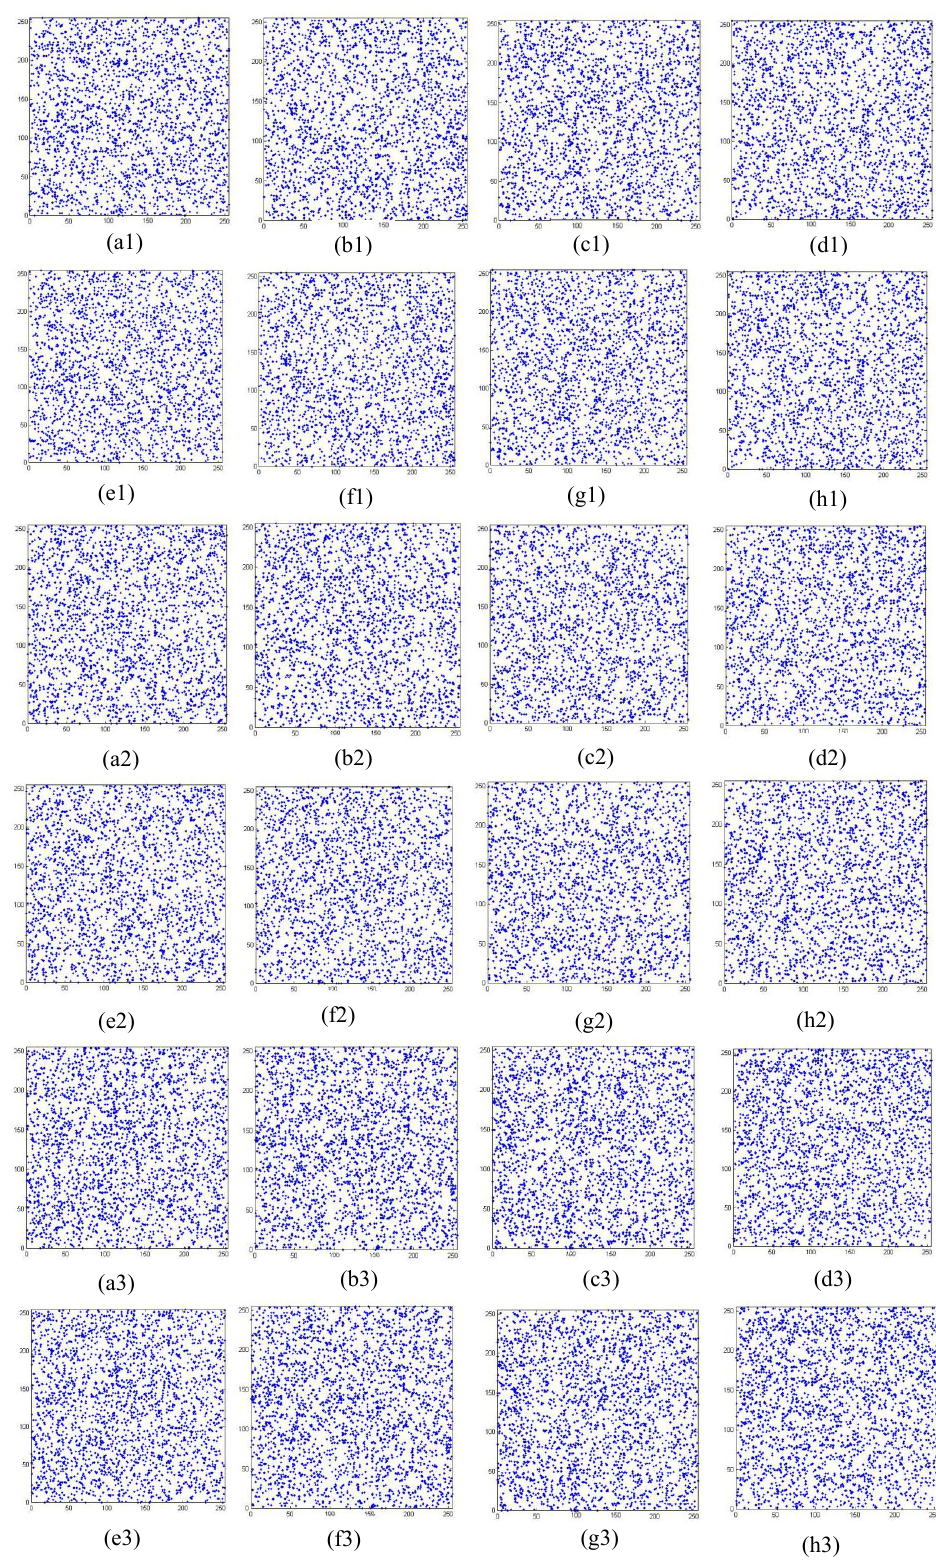
Figure 12. The adjacent pixel distributions of the four ciphertext images. ( a1 – h1 ) The adjacent pixel distributions of the four ciphertext images in the horizontal direction, ( a2 – h2 ) in the vertical direction, and ( a3 – h3 ) in the diagonal direction.